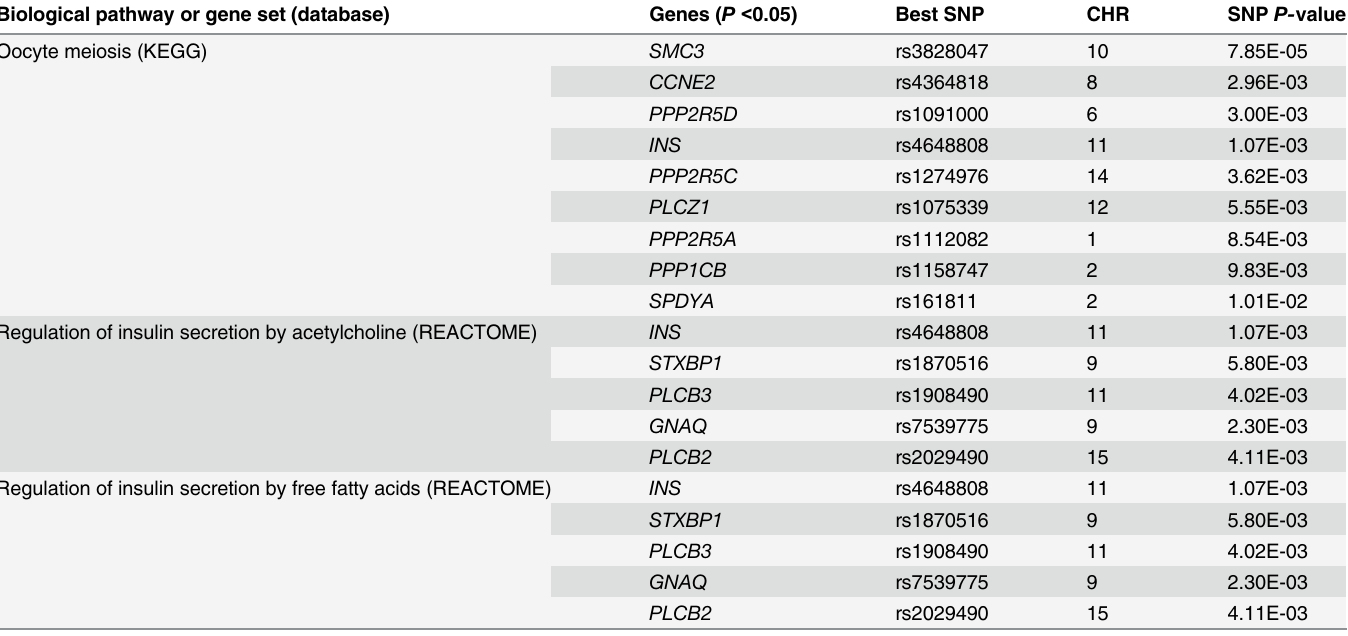
Table 3. Significant genes within the biological pathways or gene sets associated with polycystic ovary syndrome. Biological pathway or gene set